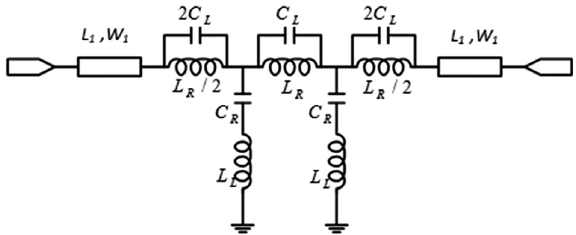
Figure 5. Schematic of a 50 X DL TL for: L 1 = 16.25